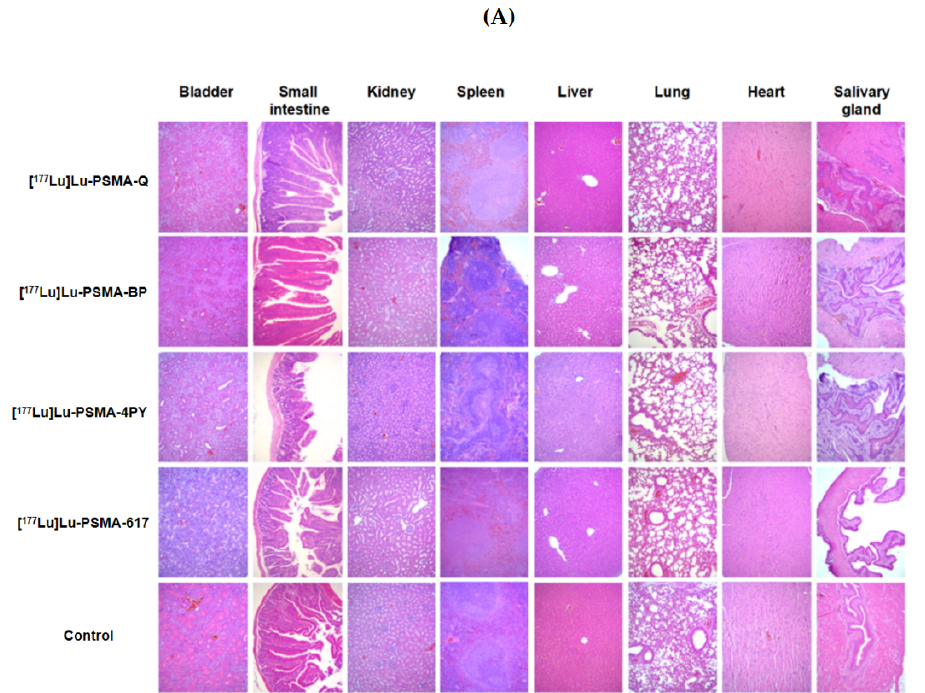
Figure 10. Radiotoxicity evaluation of [ 177 Lu]Lu-PSMA-R and [ 177 Lu]Lu-PSMA-617 (74 MBq/mouse) in ICR mice ( n = 5/group). ( A ): Results of HE staining of the main organs (kidney, heart, liver, spleen, salivary glands, small intestine, bladder, lung) of mice in the experimental and control groups ( B ): Results of routine blood tests of mice in the experimental and control groups. (WBC: white blood cell count, PLT: platelet counts, RBC: red blood cell count. Values were expressed as the mean ± SD, n = 10, ns means not statistically significant).